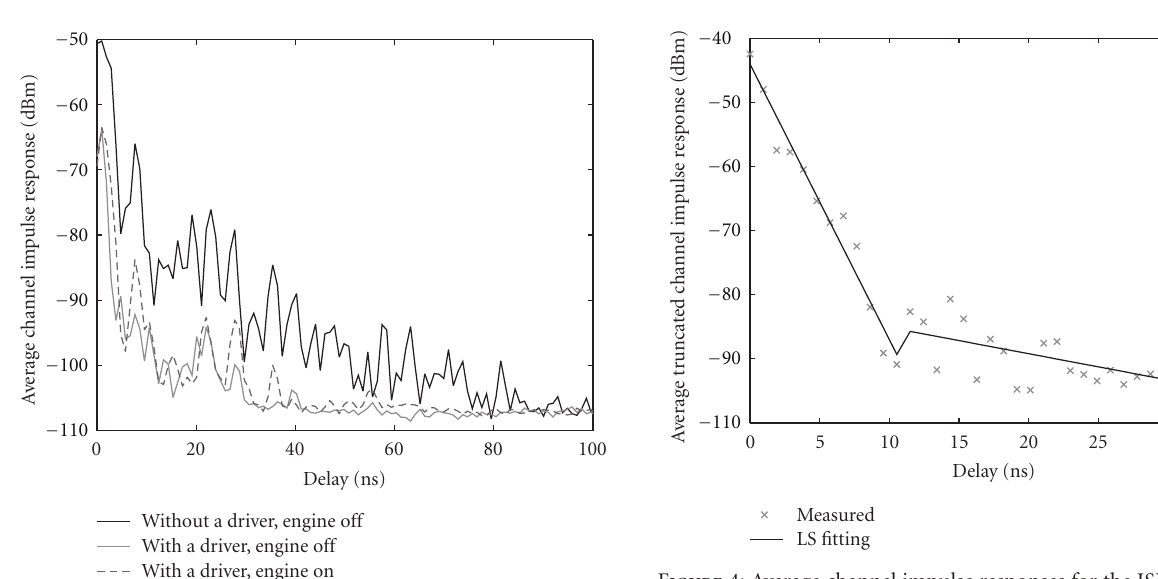
Figure 3: Average measured channel impulse responses for the ISM band, Rx5 (OLOS), in three di ff erent scenarios.